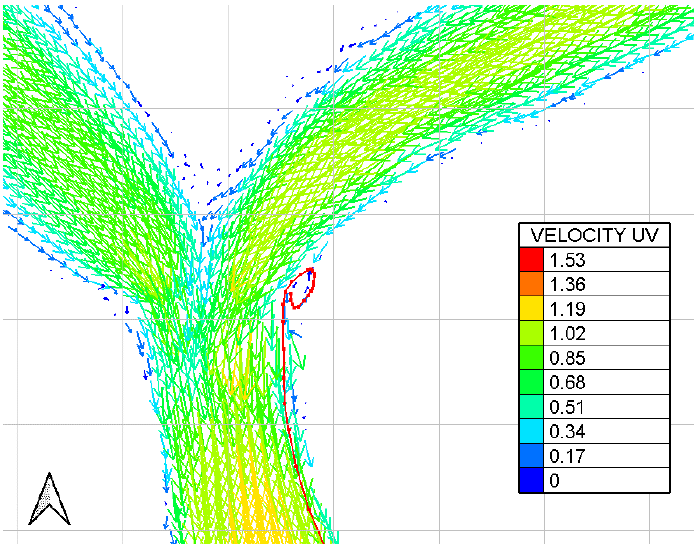
Figure 3. Average flow velocity (VELOCITY UV) in the flood season in 2009